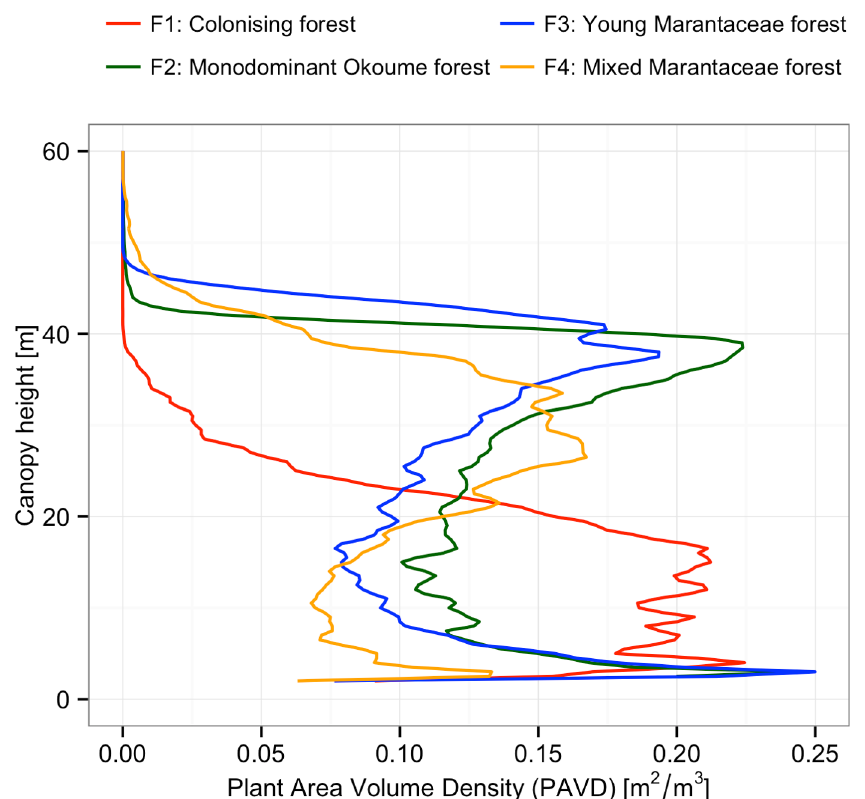
Fig 6. Mean vertical profiles per vegetation